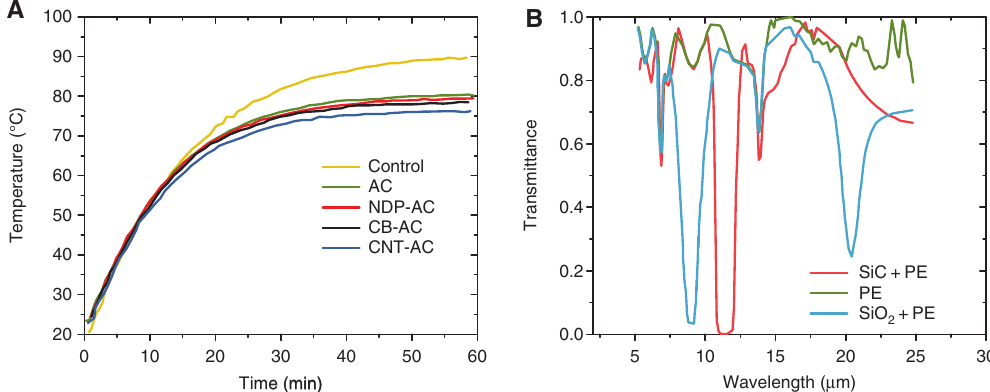
Figure 5: (A) Operating temperature vs. time for carbon-based nanomaterial-composite coolers. The cooler with multiwall carbon nanotubes (CNT-AC) gives the best performance. Adapted with permission from [60]. Copyright (2009) American Chemical Society. (B) The transmit- tance spectrum of SiO nanoparticles in polyethylene binder (blue) and SiC nanoparticles in polyethylene binder (red). The transmittance 2 spectrum of the polyethylene film itself [61] is shown in green. The two nanoparticle emission peaks are complementary to each other, and both fit within the atmospheric transparency